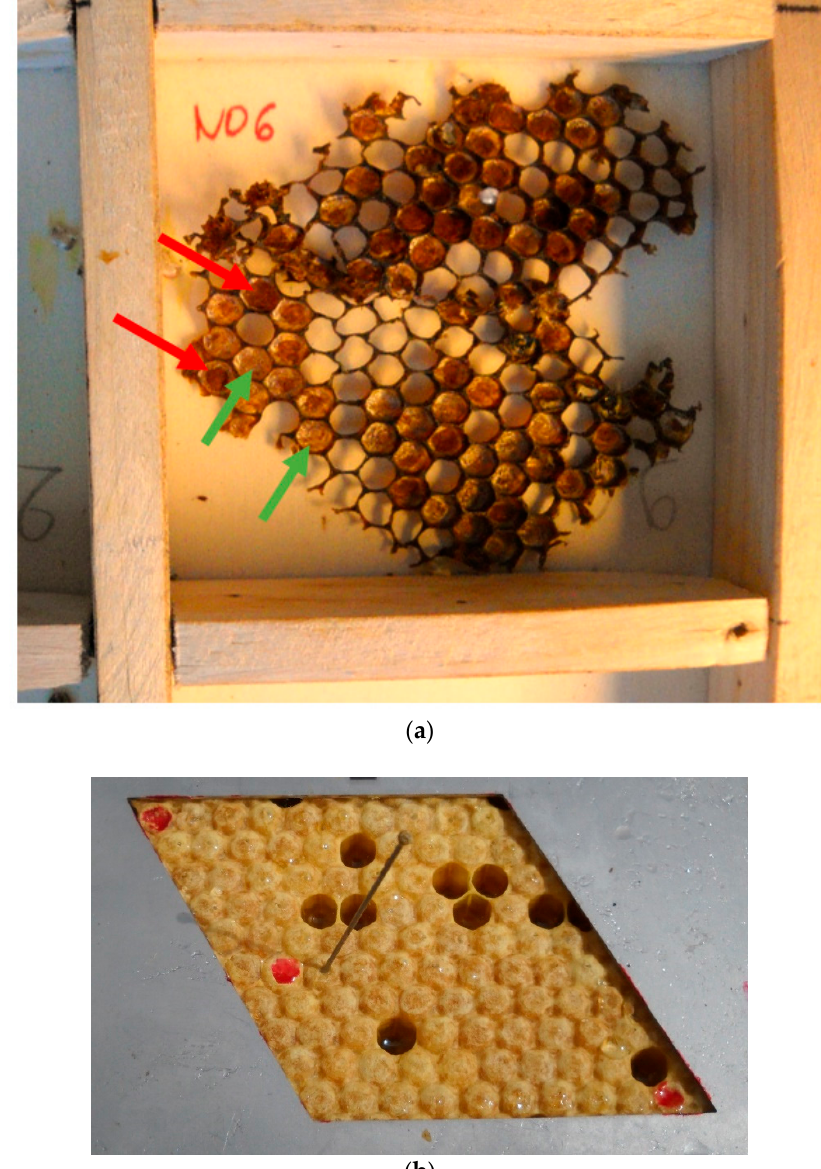
Figure 1. Illustration of ‘ Recapping ’ and ‘ Solidness ’ evaluation protocols. ( a ) Illustration of the evaluation procedure of the ‘ Recapping ’ trait. Cell cap samples are taken from a single colony and stored in their transportation box to be taken from the field to the evaluation desk. Some recapped cells are already clearly visible (e.g., those marked with red arrows) whereas others show an intact silk cocoon (e.g., those marked with green arrows). The sample is later taken out and examined under a stereomicroscope (×4) ( b ) Illustration of the evaluation procedure of the ‘ Solidness ’ trait. A pin-test was performed using an entomological pin. The upper red dot indicates the initial (non-pinned) pupa, then 50 pupae are pinned and the following (non-pinned) pupa gets another red dot (in the middle). Lowest red dot is used to place the template back to the test area when recording pin-test result. Between the upper two marks (delimitating 50 pin-killed pupae), 57 cells had to be checked to find 50 cells to pin (7 cells were empty). Here, observation value for ‘ Solidness ’ is 57.